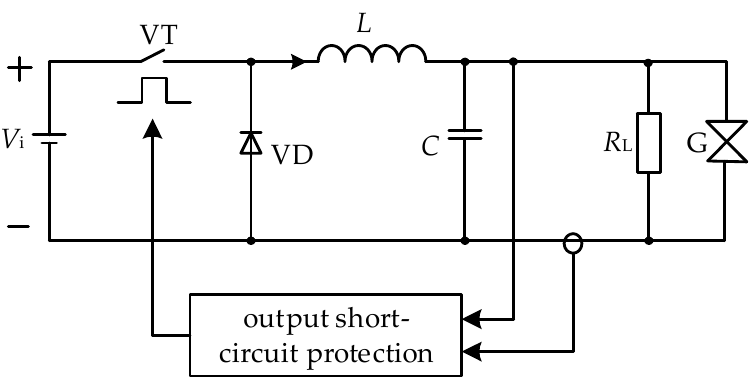
Figure 2. Output short test circuit of the Buck converter.